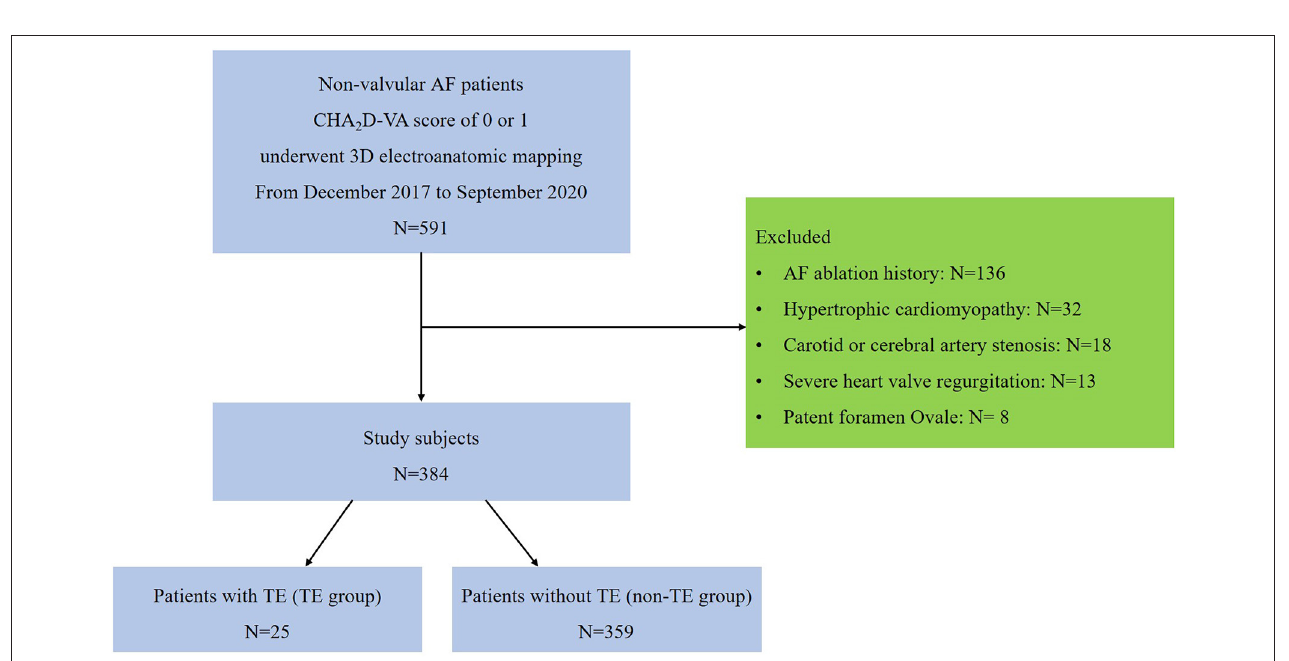
FIGURE 2 | Flow diagram showing the process for selecting our study patients. AF, atrial fibrillation; TE, thromboembolism.